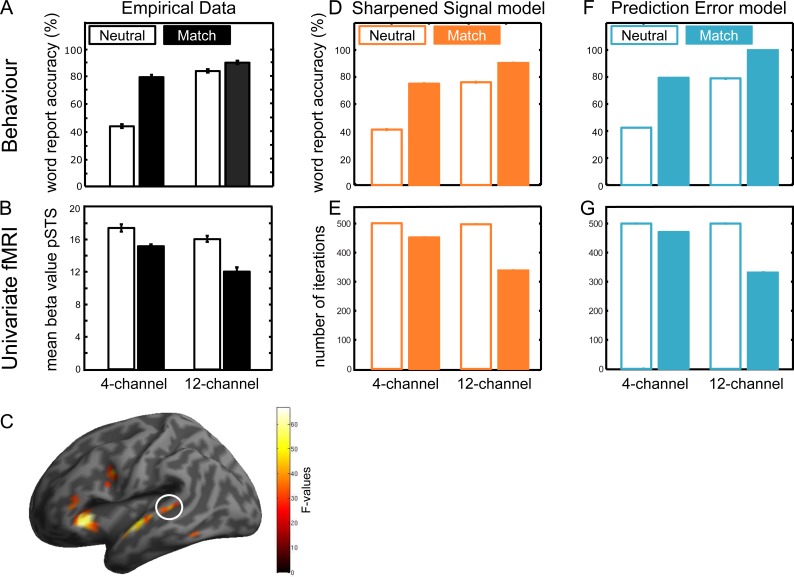
Comparison of behavioural and univariate fMRI results with model output.(A) Behavioural results. Matching expectations and increased sensory detail improved perception of degraded spoken words. (B) Univariate results. Mean beta values extracted from the posterior STS (pSTS, MNI: x = -52, y = -38, z = 6) show reduced BOLD signal during Match conditions (solid) in contrast to Neutral conditions (open). Error bars for the empirical data indicate standard error of the mean after between-subject variability has been removed, which is appropriate for repeated-measures comparisons [62]. (C) Main effect of prior expectations rendered on a canonical brain (p < 0.05 voxelwise FWE, n = 21). White circle marks the region of interest in the posterior STS. (D/E) Sharpened Signal model (orange) and (F/G) Prediction Error model (blue). For comparison with the behavioural results (D/F) we assessed word recognition accuracy in the model based on the final lexical representation (i.e., which word the model selected as presented), and for comparison with the univariate results (E/G) we assessed the number of activation updates required to reach the stopping criterion. Error bars for both simulations indicate the standard error of the mean over 1,000 replications. Please refer to S1 Data at https://osf.io/2ze9n/ (doi: 10.17605/OSF.IO/2ZE9N) for the numerical values underlying these figures.